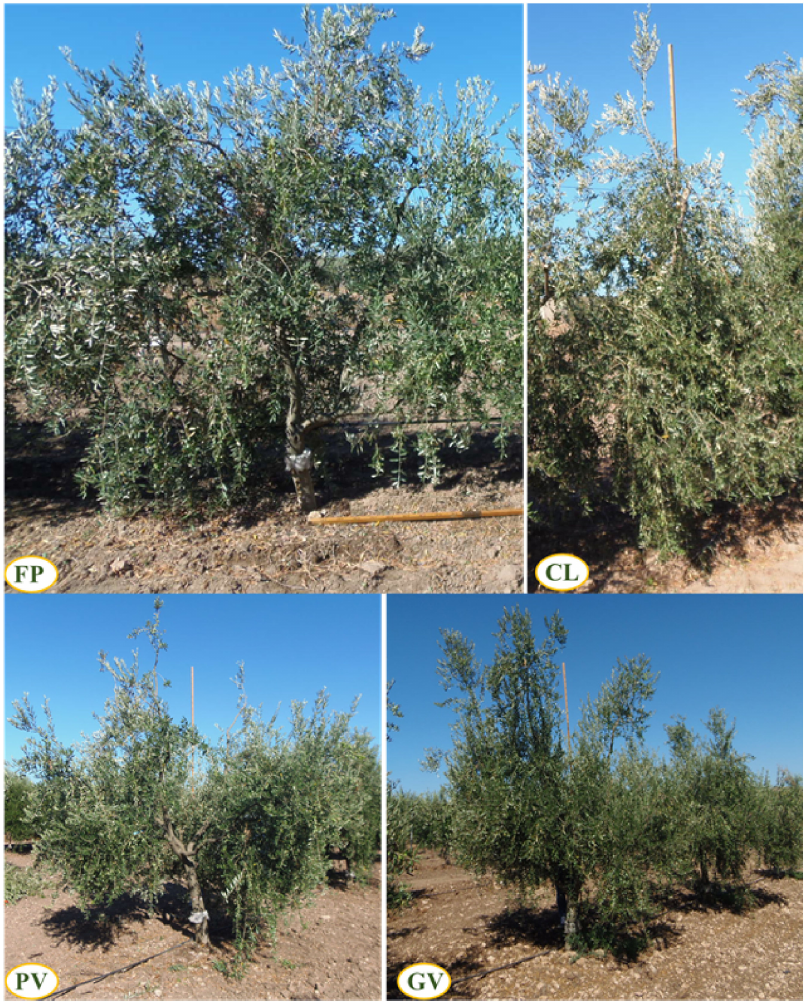
Figure 1. Examples of ‘Calatina’ olive trees trained to free palmette (FP); central leader (CL), with a planar canopy shape; polyconic vase (PV); and small globe vase